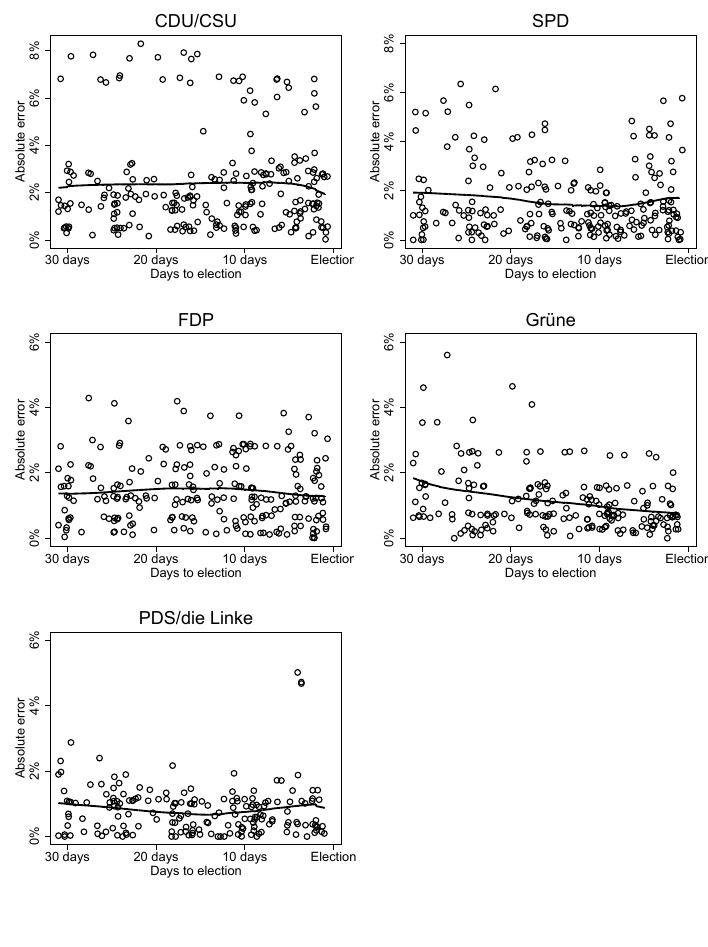
Figure 5 : Absolute error of the poll results depending on the number of days to the election. The scatterplot-smoother is Loess with